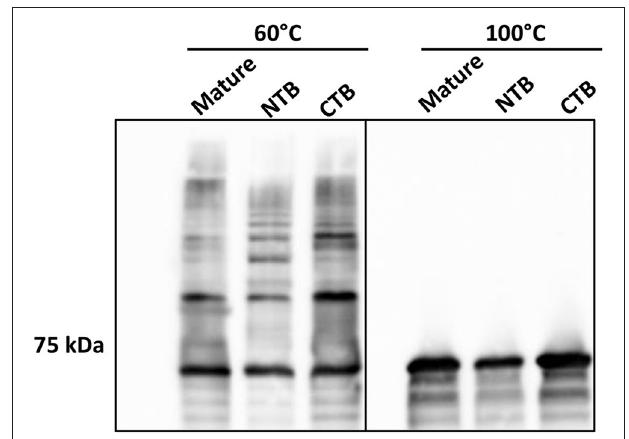
FIGURE 5 | N-terminal and C-terminal deletion mutants of Mfa1 fail to polymerize. Mfa1 proteins corresponding to pre-Rgp processed form (precursor), post-Rgp processed form (mature), and either C-terminally truncated ( 1 -C) or N-terminally truncated ( 1 -N) forms were treated separately at either 60 ◦ or 100 ◦ C prior to SDS-PAGE and immunoblotting with antibodies to Mfa1. Results are representative of 3 biological replicates.